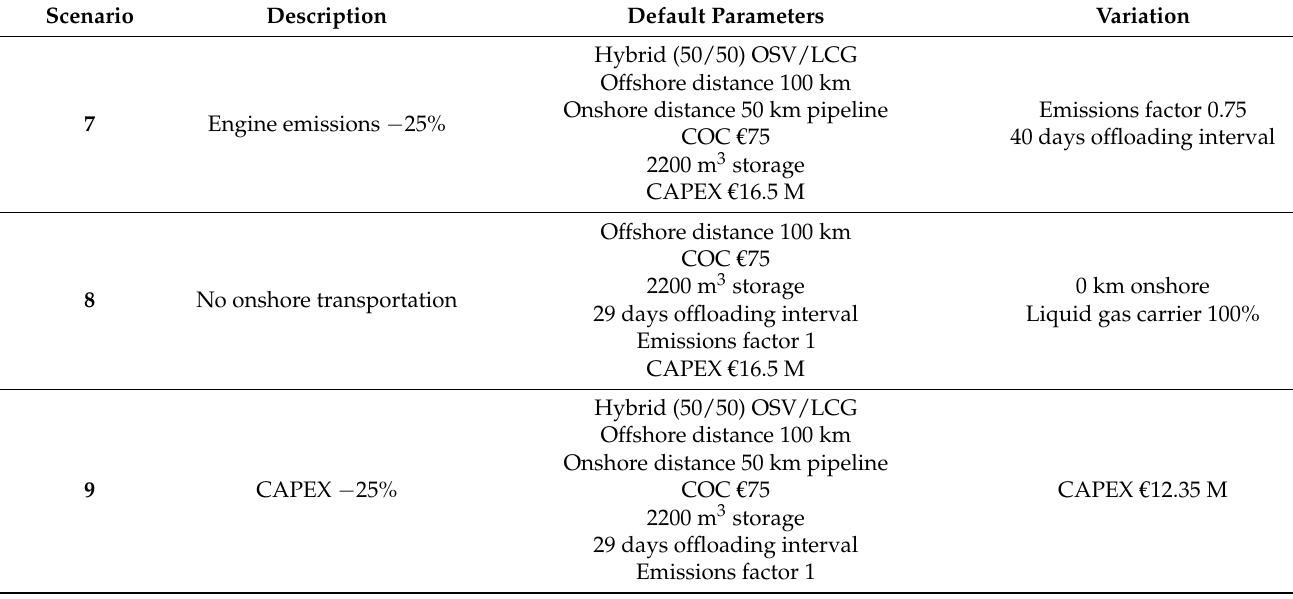
Table A4. Overview of scenarios 7, 8 and